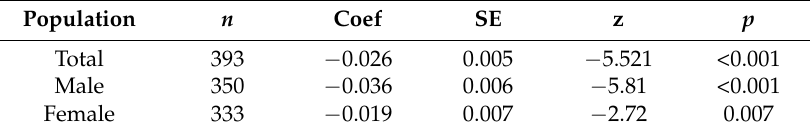
Table 6. Adjusted Poisson log-linear model with mean arsenic level, ≥ 80% dependency and maximum arsenic ≤ 50 µ